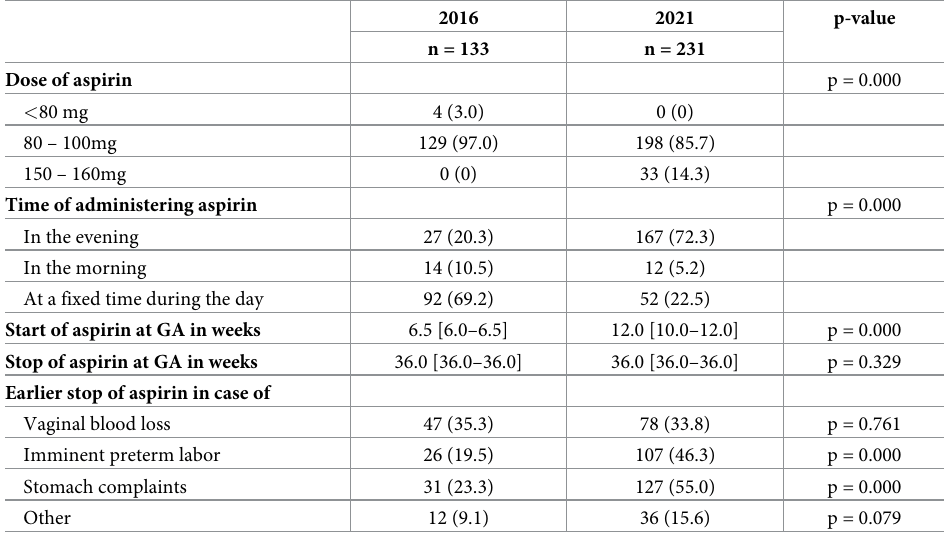
Table 2. Gynecologists’ advices on prescription of aspirin in 2016 and 2021.